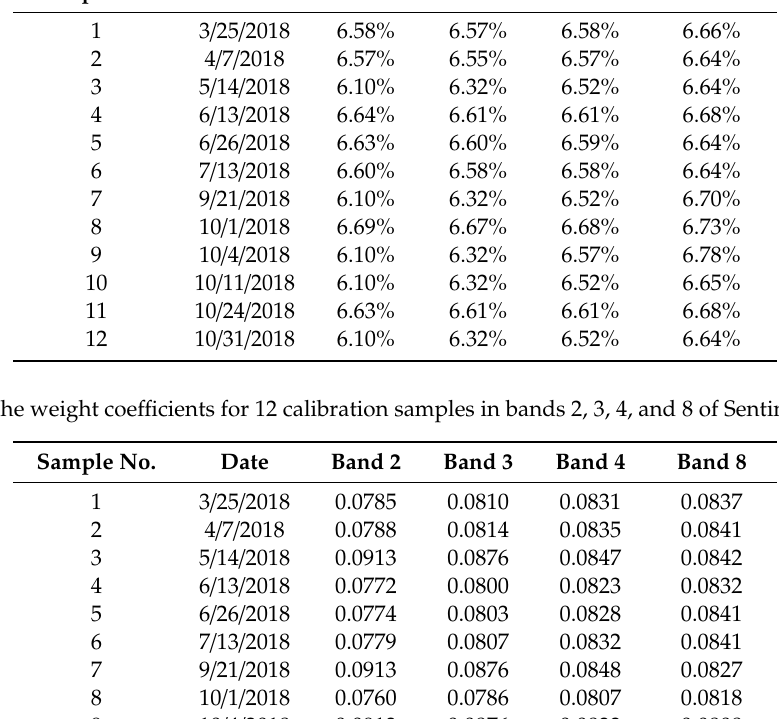
Table 8. The adjusted uncertainties for 12 calibration samples in bands 2, 3, 4, and 8 of Sentinel-2B / MSI. Sample No.